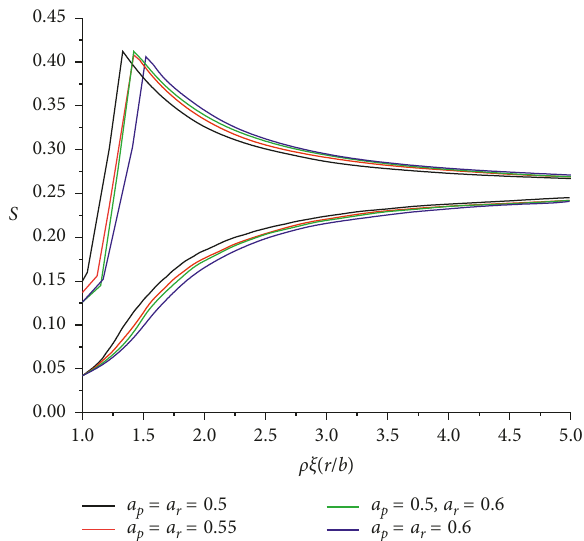
a a p = r = 0.5 a a p = r = 0.55 Figure 14: Distribution of radial and circumferential stresses for different values of a .